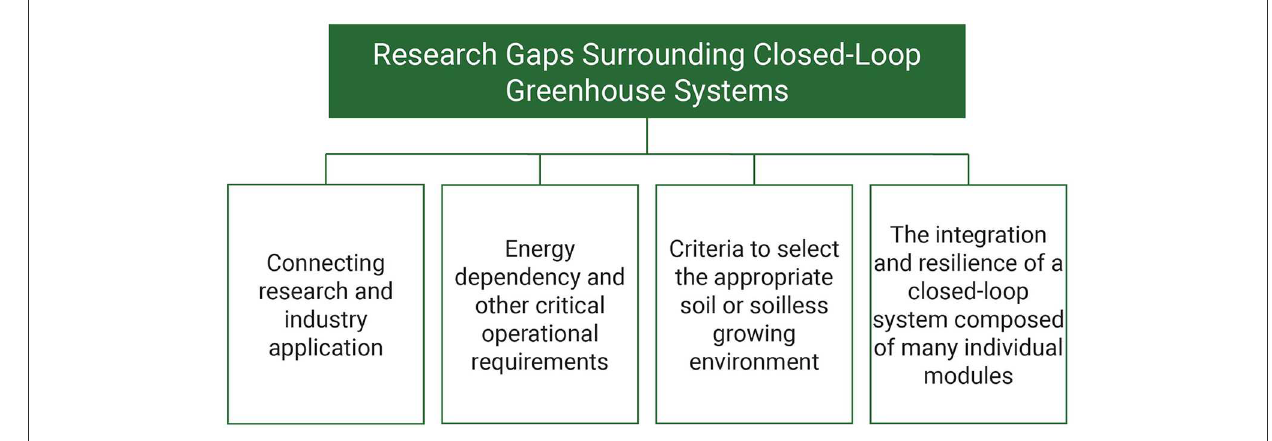
FIGURE8 Future avenues of research and